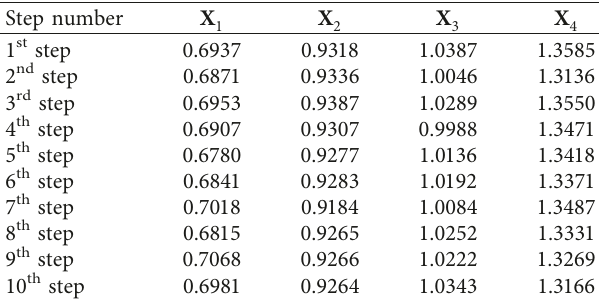
Table 2: Estimated true value X the